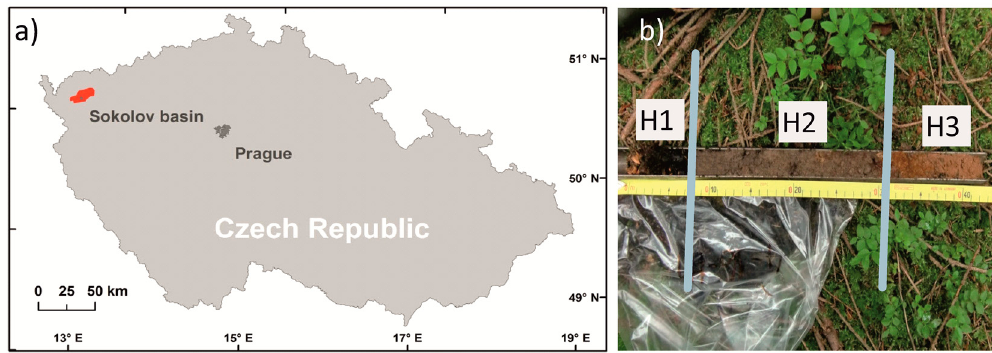
Figure 1. ( a ) Diagram showing geographic positions of the sampled soils; ( b ) organo–mineral horizon H2 (A + AB, depth of 10–30 cm) determination.